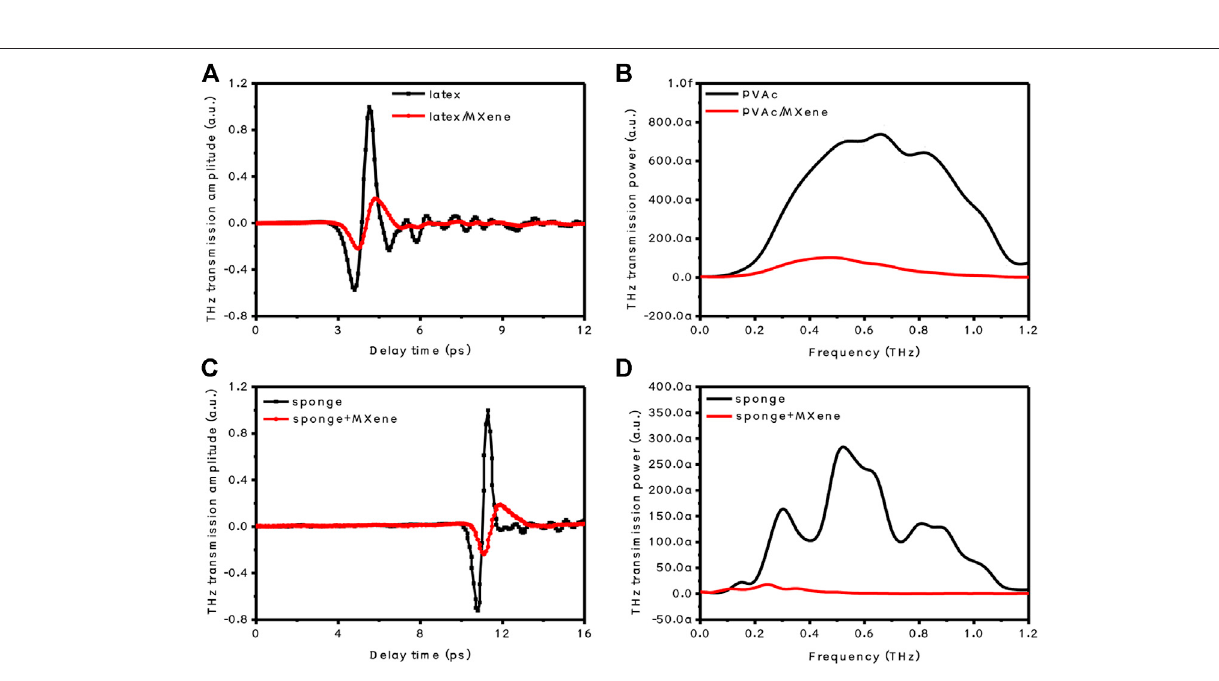
Frontiers in Physics |